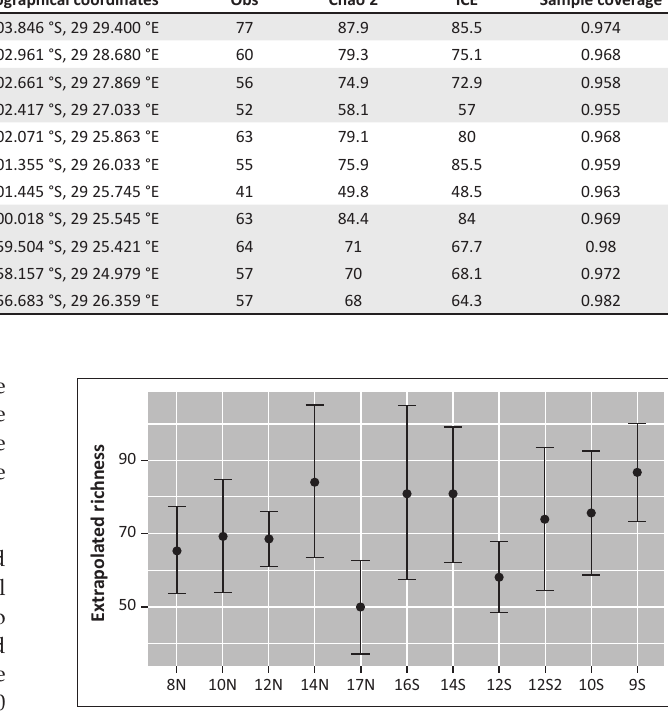
FIGURE 4: Extrapolated species richness for each site and 95 % confidence intervals based on unconditional variance, from 1000 pitfall samples for each of the 11 sites across the Soutpansberg Mountain